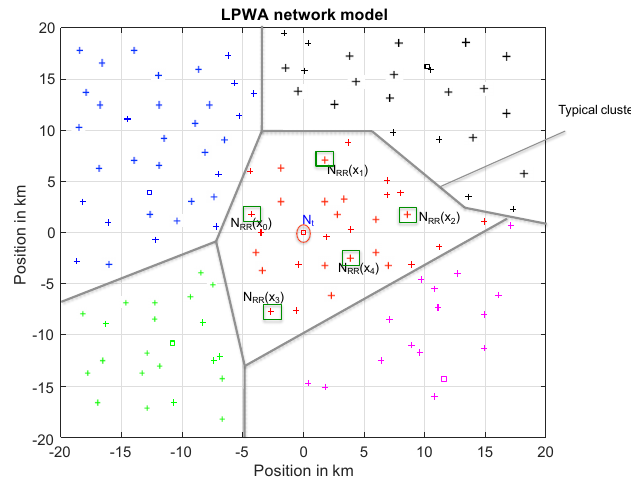
Figure 1. Network model: typical cell and active